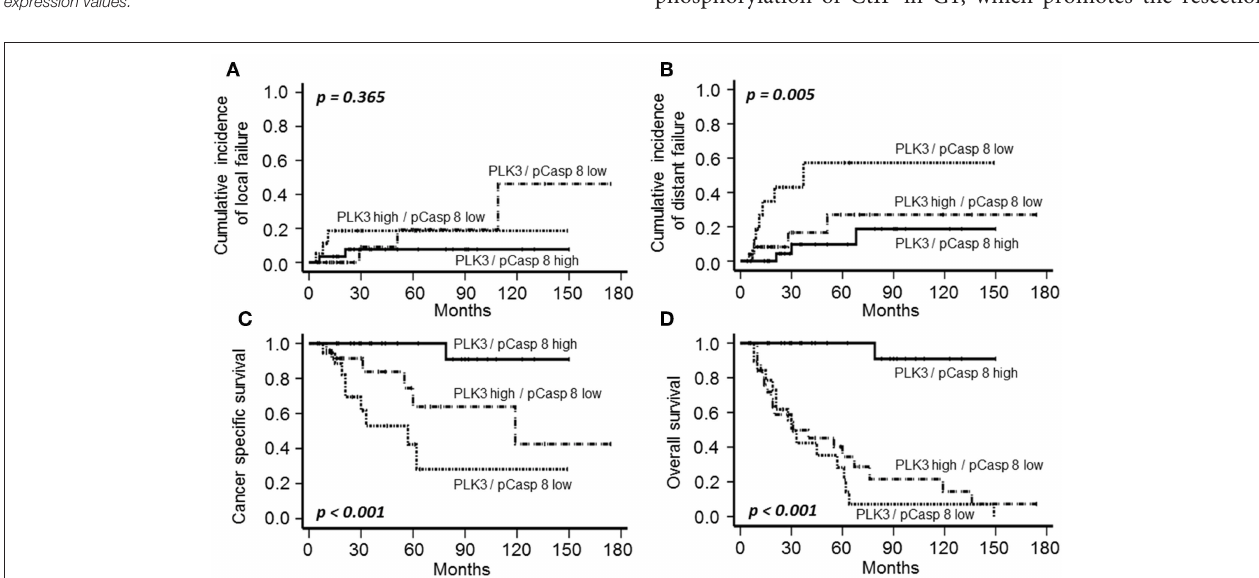
FIGURE 5 | Cumulative incidence of local (A) and distant failure (B) , CSS (C) , and OS (D) according to PLK3 and T273 Caspase 8 phosphorylation (high PLK3 and high pCasp 8 vs. high PLK3 and low pCasp 8 vs. low PLK3 and low pCasp 8) in patients with CSCC treated with definitive CRT and BT.